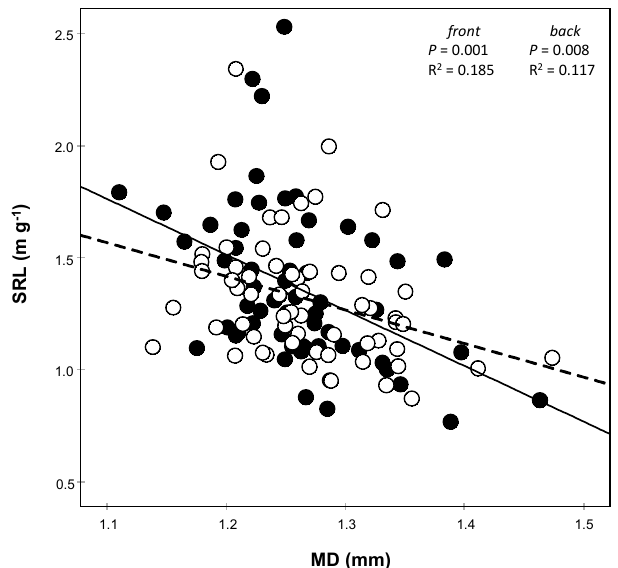
Figure 3. Relationship between specific root length (SRL) and mean diameter (MD) of the 1–2 mm diameter fine root class according to the front (filled circle) and back (empty circle) core positions. Each point represents the mean of 4 replicates ± SE. Continuous and dashed lines represent front and back linear interpolations, respectively.